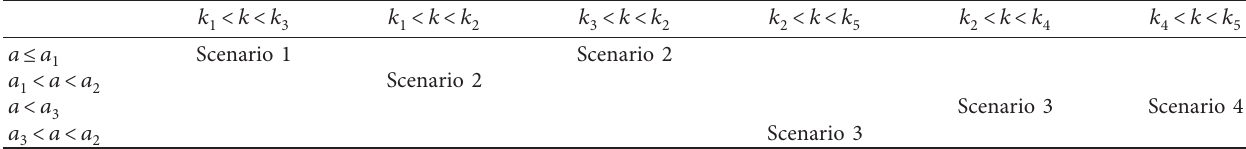
Table 4: Four scenarios and the corresponding parameter value range.